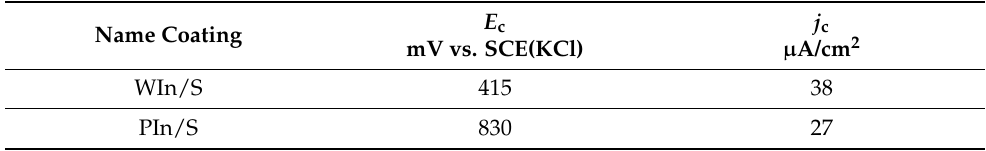
Table 4. Potential and critical current density of Inconel 625 coatings onto the S235JR